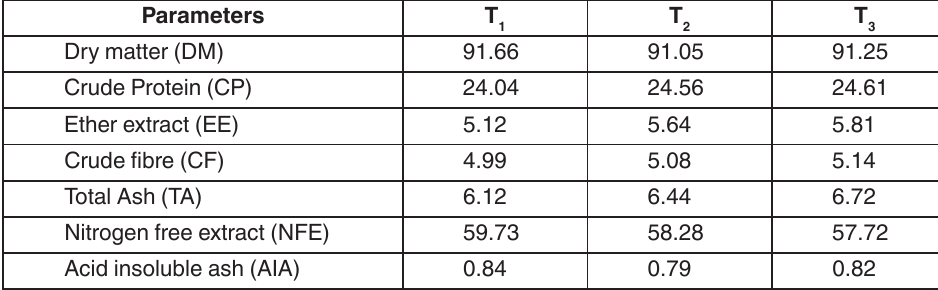
table 1. Chemical composition of experimental feed % (DM basis) Parameters